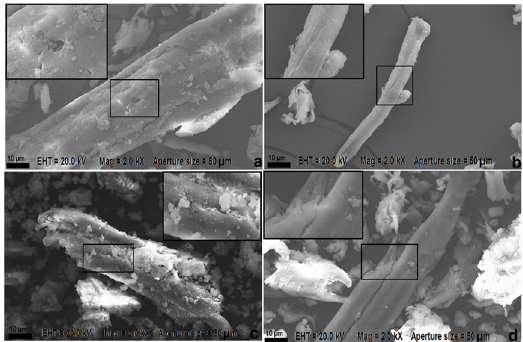
Figure 2. Scanning electron microscopy images of different fiber surfaces: a) "In natura", b) treated with NaOH, c) treated with Ca(OH) , d) treated with hot water (75ºC). 2